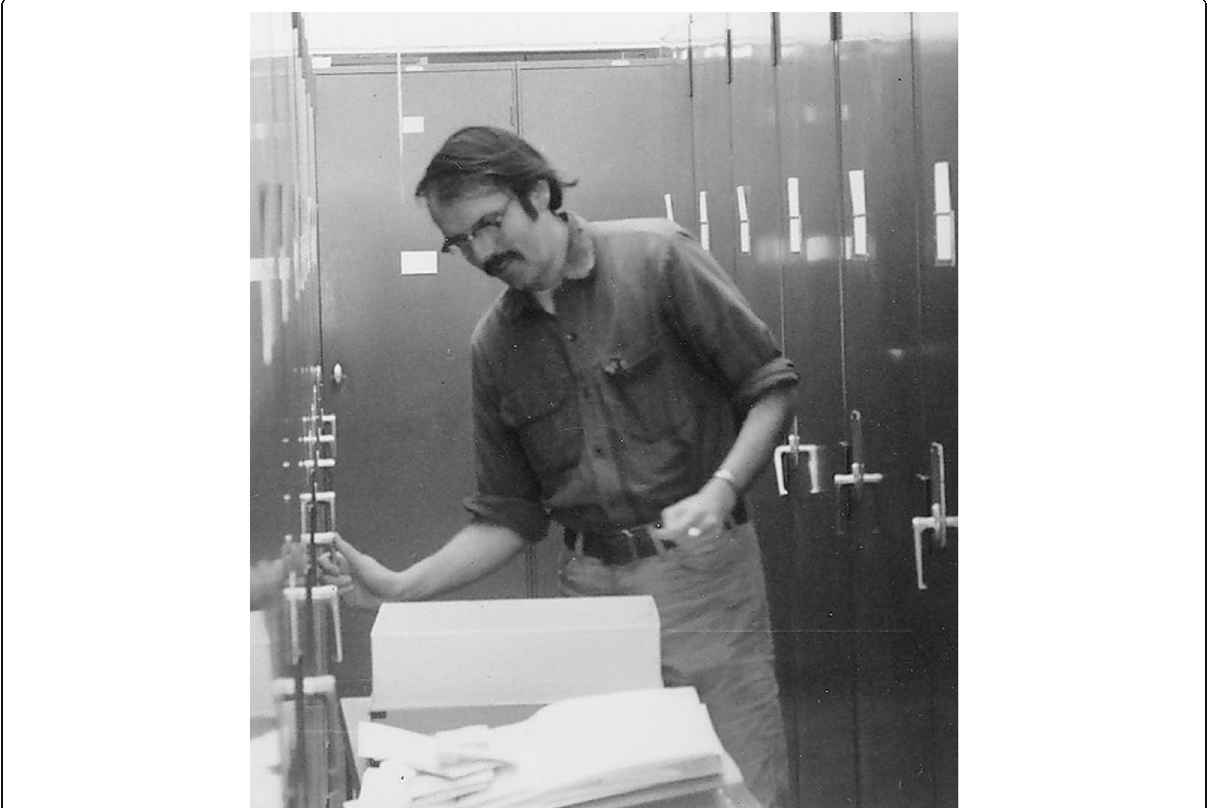
Fig. 25 Richard C. Harris at work in